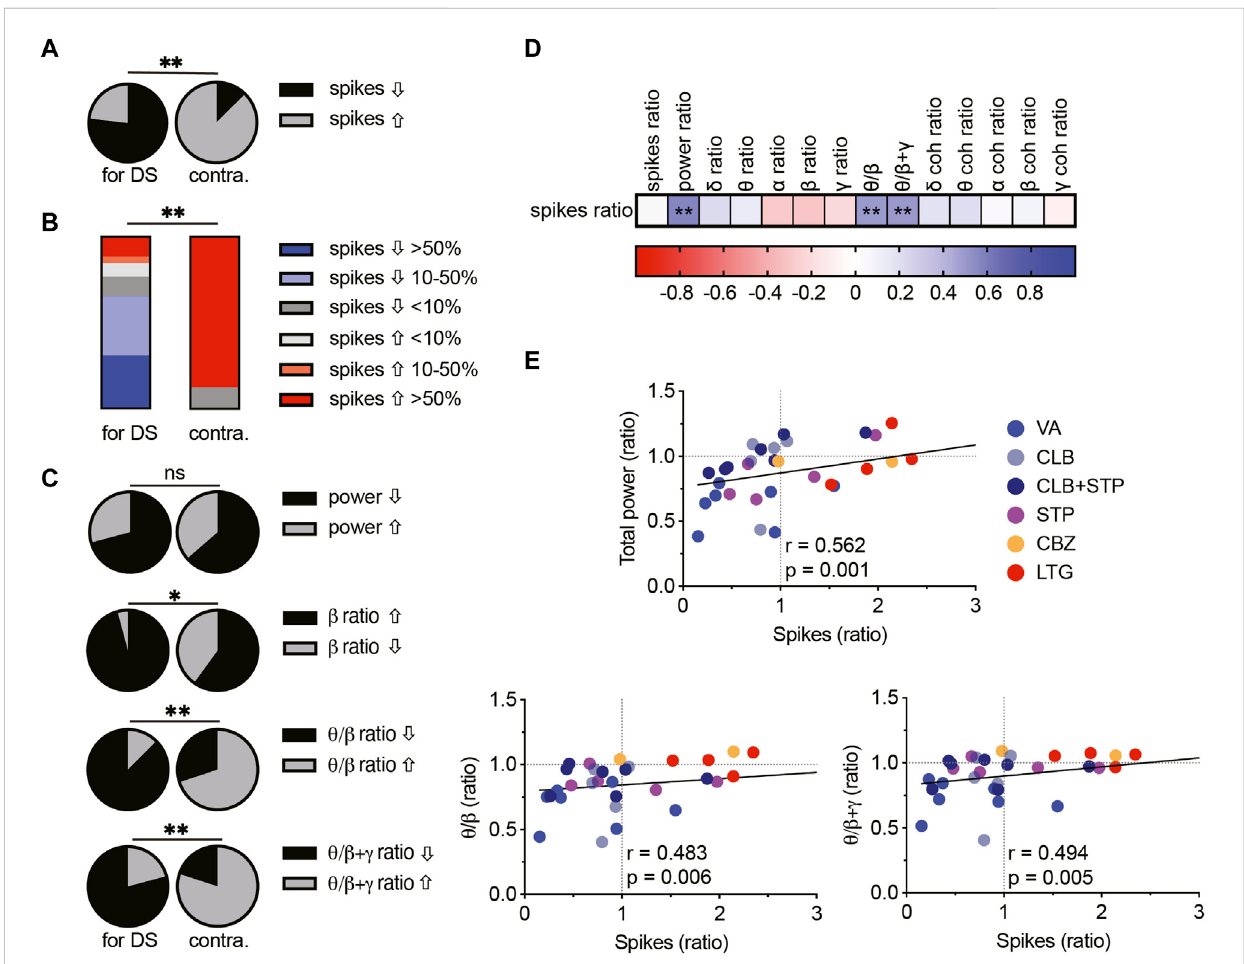
FIGURE 8 Correlationsbetween spike frequency and spectral parameters in DS mice. (A) The proportion of mice with increased or decreased spike frequency amongprescribed(left,VA,CLB,CLB+STP,STP)andcontraindicated(right,CBZ,LTG)ASMsinDSmice. (B) Percentagesofmiceandtheirchangeinspike frequency following treatment with prescribed (left) and contraindicated (right) ASMs. (C) The proportion of DS mice, treated with prescribed (left) and contraindicated (right) ASMs with increased or decreased total power, beta contribution, theta/beta relative power ratios, or theta/(beta + gamma) ratios. (D) Correlation matrix (Spearman correlation) between the change in the frequency of interictal spikes, background spectral parameters, and the coherence (coh). The change was calculated as the ratio between a speci fi c parameter after ASM administration divided by the same parameter before ASMs. Full correlation analysis is presented in Supplementary Fig. 5. A full description of the correlation coef fi cients and statistical signi fi cance are presented in SupplementaryTable 1. (E) Correlationsbetween thechange inspike frequency and thetotalpower(top),thetheta/beta ratio(bottom, left), andthetheta/(beta+gamma)ratio(bottom,right).ThetextindicatestheSpearmancorrelationcoef fi cientandstatisticalsigni fi cance.Thesolidblackline depicts the fi t. * p < 0.05, ** p <